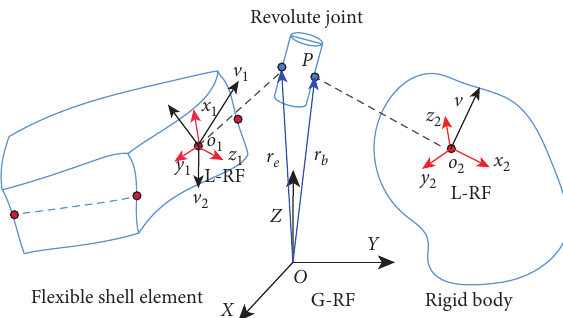
Figure 5: Kinematic description of the revolute